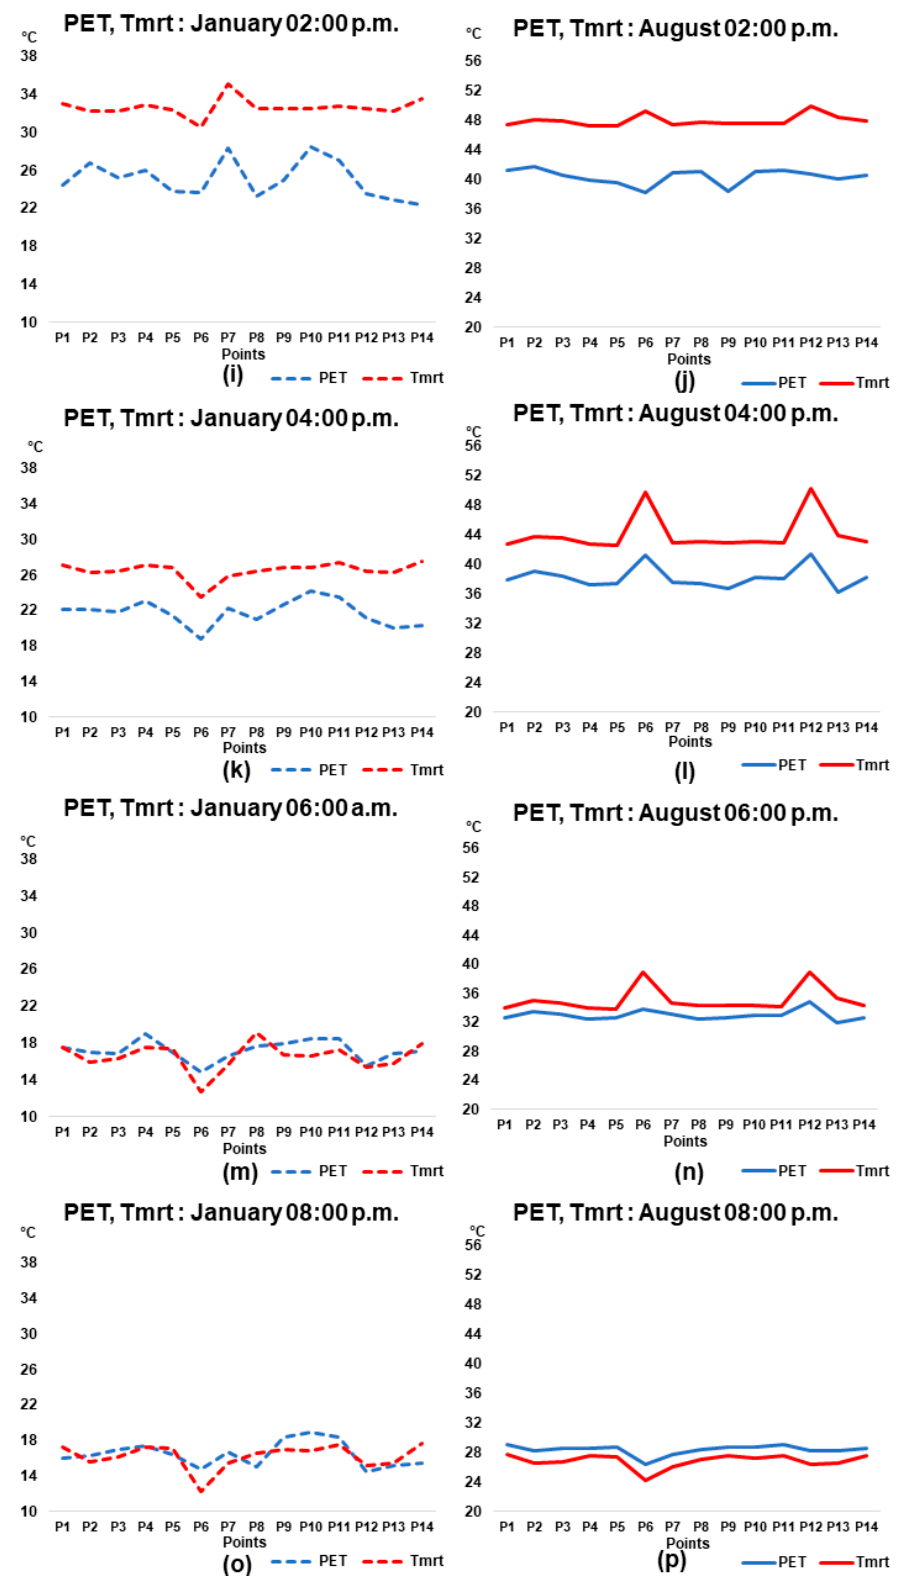
Figure A4. Variations between PET and Tmrt at the 14 studied points depending on the SVF in January ( a , c , e , g , i , k , m , o ) and August ( b , d , f , h , j , l , n , p ) from 6:00 a.m. to 8:00